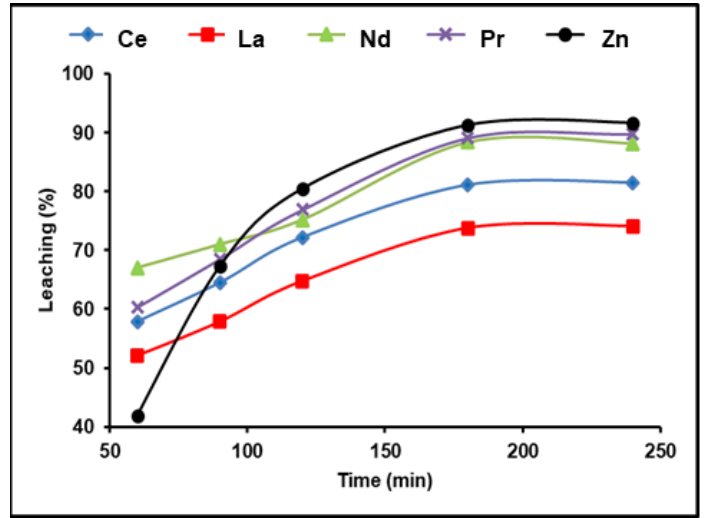
Figure 3. Influence of time on the dissolution of REEs and Zn from spent Ni ‒ MH battery powder ◦ C, 1:2 (S/L) (300 g/L (NH 4 ) 2 SO 4 , T: 90 °C, 1:2 (S/L) ratio). (300 g/L (NH 4 ) 2 SO 4 , T: 90